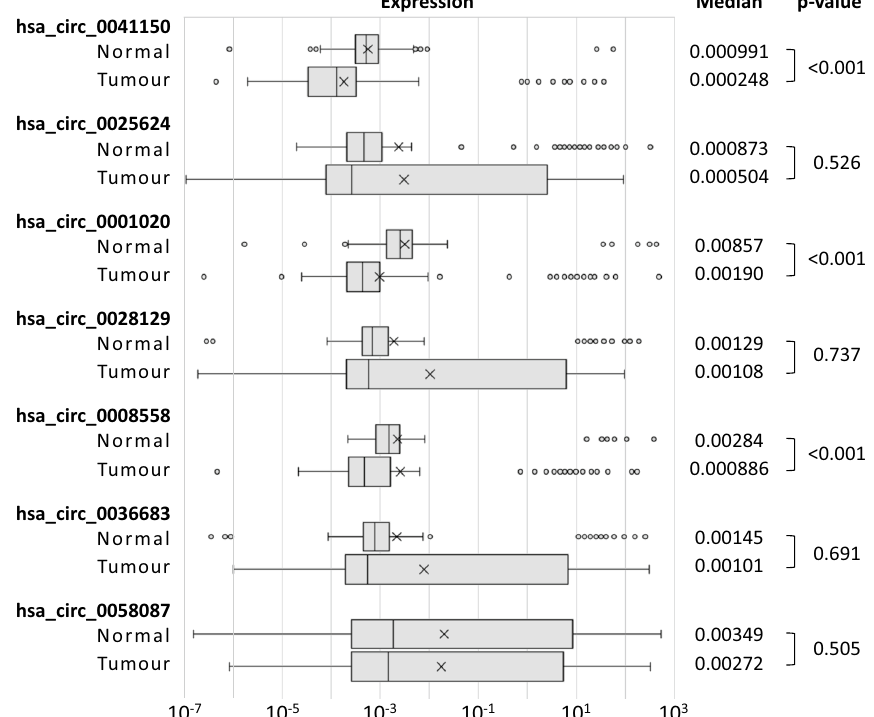
Figure 2. Expression analysis of selected circRNAs in HCC and background normal liver. The figure is prepared using Excel (Microsoft,